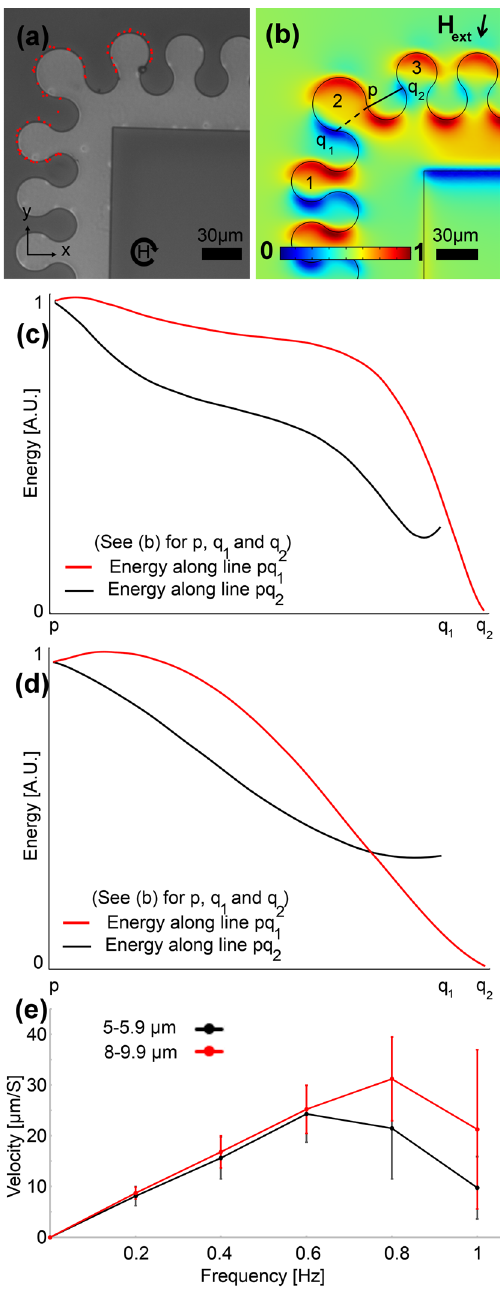
Figure 5. A sample appropriate magnetophoretic bend design. ( a ) The experimental image is shown, where the red dotted line stands for the particle trajectory. The circular arrow depicts the magnetic field rotation. ( b ) The magnetic energy landscape simulation result above the substrate is illustrated. The blue and red areas stand for the regions with low and high magnetic energies, respectively. Here, we did a min–max normalization to scale the magnetic energy between 0 and 1 (see the legend). The black arrow depicts the in-plane magnetic field direction, in addition to which a vertical bias field is applied. The magnetic energies along the pq 1 and pq 2 lines in ( b ) (i.e., the dashed and solid lines) are plotted with the red and black curves for a particle with a diameter of ( c ) 5 µm and ( d ) 20 µm. The goal is to transport the particles from magnet 1 to magnet 3 via magnet 2. We used a linear scale for the magnetic energy plots and we did a min–max normalization, using the minimum and maximum of the magnetic energy along the pq 1 and pq 2 paths, to scale the energy between 0 and 1. ( e ) The particle velocity versus frequency of the externally applied magnetic field is plotted with the black and red curves for two particle sets with sizes in the ranges of 5–5.9 µm and 8–9.9 µm, respectively. The error bars show standard